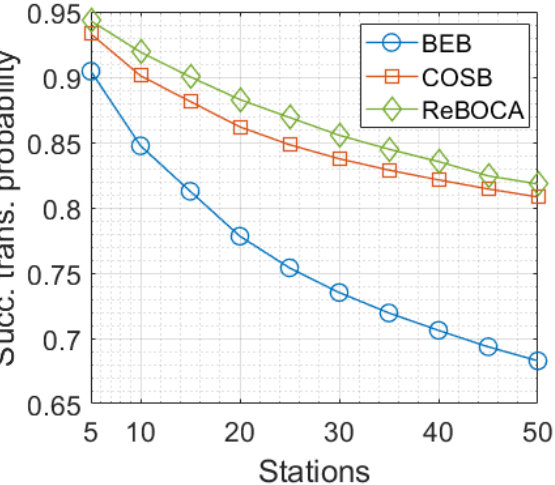
Figure 6. Comparison of probability of successful transmission ( P s ) among BEB, COSB, and ReBOCA due to change in network density.